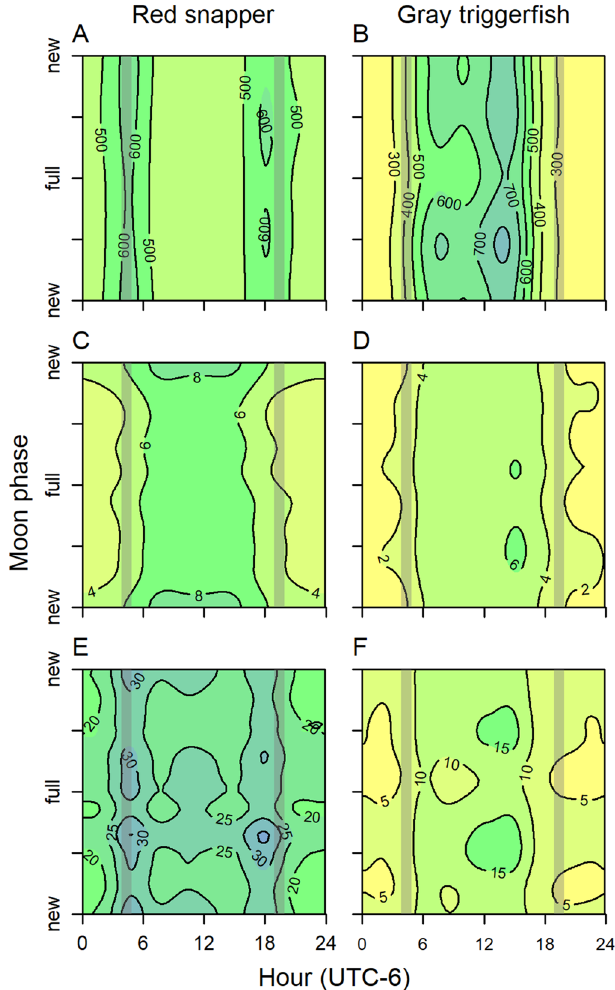
Figure 7. GAMM predicted hourly home range (m 2 ; A , B ), height above bottom (m, C , D ), and distance to reef (m, E , F ) of red snapper and gray triggerfish as a function of time of day and moon phase, for July 1. Overshaded areas represent dawn and